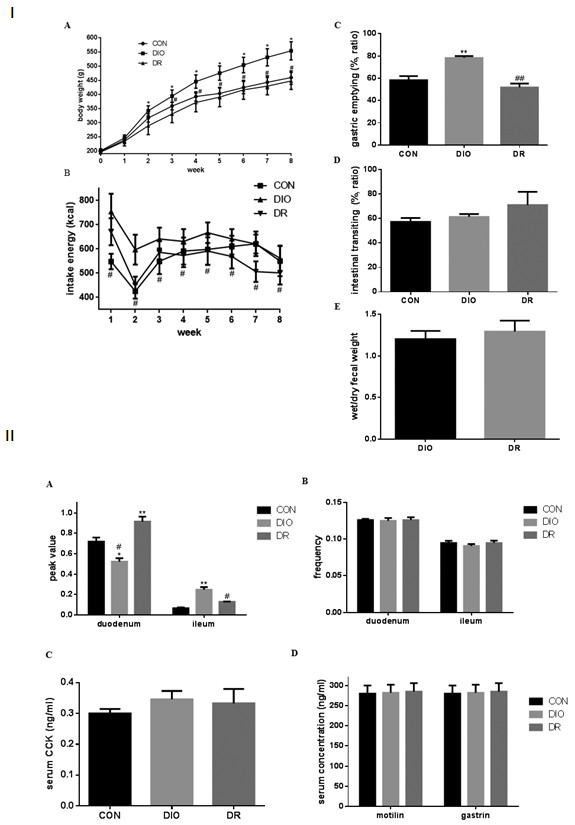
The changes of body weight and gastrointestinal motility as well as the changes of isolated small intestine segments and serum gastrointestinal hormones in food-interfered and control groups. I. A body weight; B intake of energy; C the ration of gastric empty in CON, DIO and DR groups. D the rate of intestinal transiting in CON, DIO and DR groups. E the ratio of wet/dry fecal weight in DIO and DR groups. II. A the summary of peak changes of duodenum and ileum; B the summary of frequency changes of duodenum and ileum; C the changes of serum cholecystokinin (CCK); D the changes of serum motillin and plasma gastrin. CON: the group of basic diet control; DIO: the group of diet–induced obesity; DR: the group of diet-induced resistance. *p < 0.05, **p < 0.01, compared to the CON group. #p < 0.05, ##p < 0.01, compared to the DIO group.